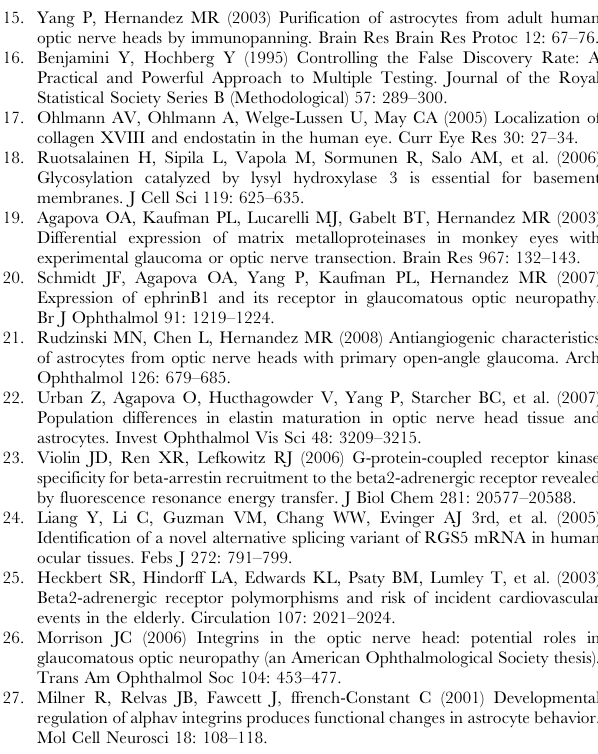
Table S5 Selected Gene ontology for AA-CA comparison. Gene Ontology for genes differentially expressed in AA ONH astrocytes compared to and CA ONH astrocytes.